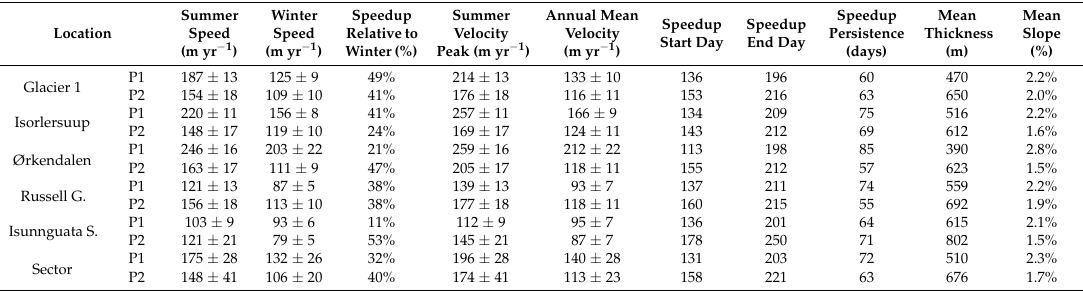
Table 1. Seasonal velocity, speedup, speedup persistence, ice thickness and surface slope of the five glaciers averaged in two elevations bands (P1, between 650 and 750 m.a.s.l.; P2, over 820 m.a.s.l.). Summer Location Speed (myr − 1 )